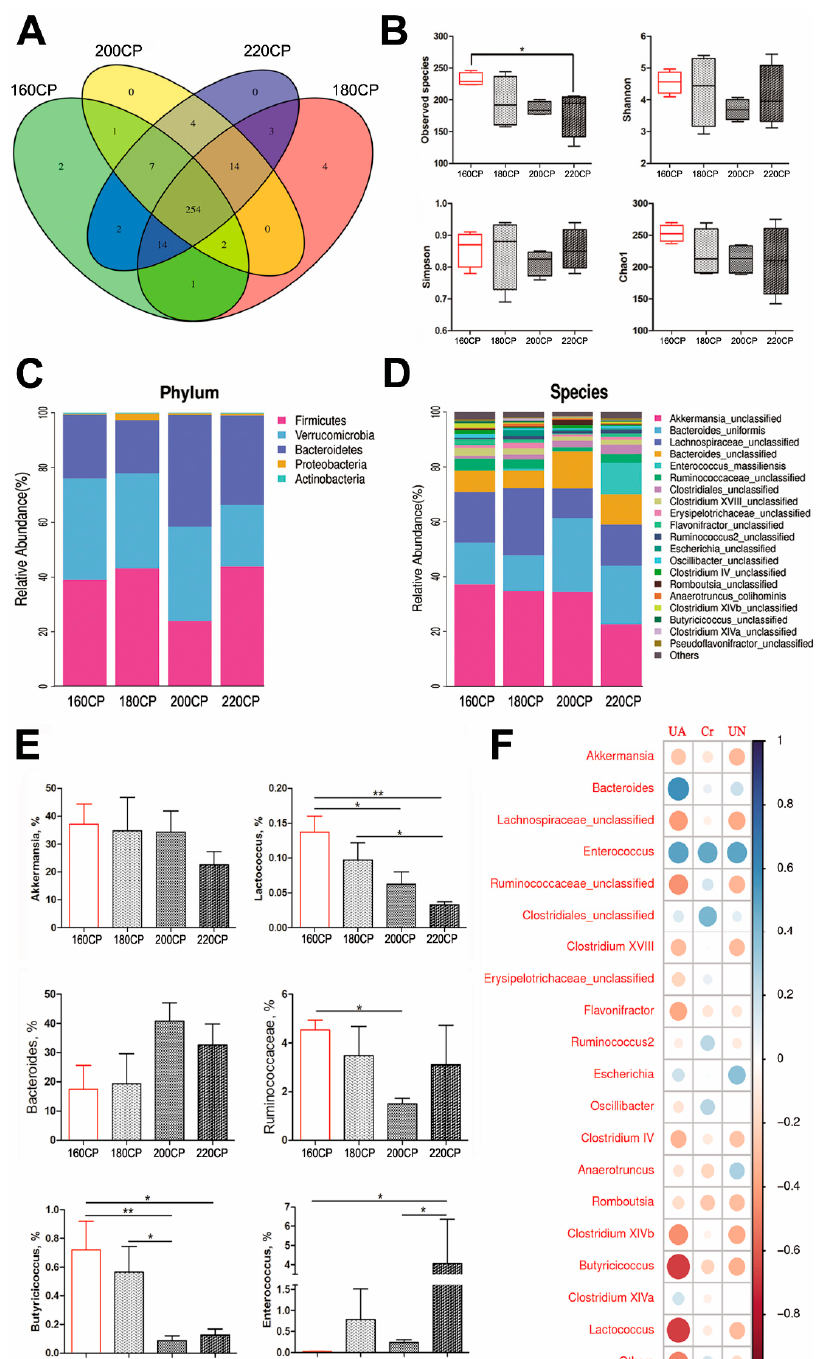
Figure 2. The degrees of gut dysbiosis in cecum of goslings with di ff erent protein diets. ( A ) Venn diagram of the observed species; ( B ) total observed species and alpha diversity indexes, n = 6; ( C , D ) microbiome composition at the phylum and species levels, n = 6; ( E ) the average abundances of some genera among groups, n = 6; ( F ) correlation analysis between the abundant genera and the serum concentration of UA, Cr, and BUN in goslings with di ff erent protein diets by the R program. The circle size and color intensity represent the magnitude of correlation. Blue circle = positive correlation; red circle = negative correlation. UA: uric acid, Cr: creatinine, BUN: blood urea nitrogen. Asterisks represent di ff erences between groups being significant (* P < 0.05, ** P <